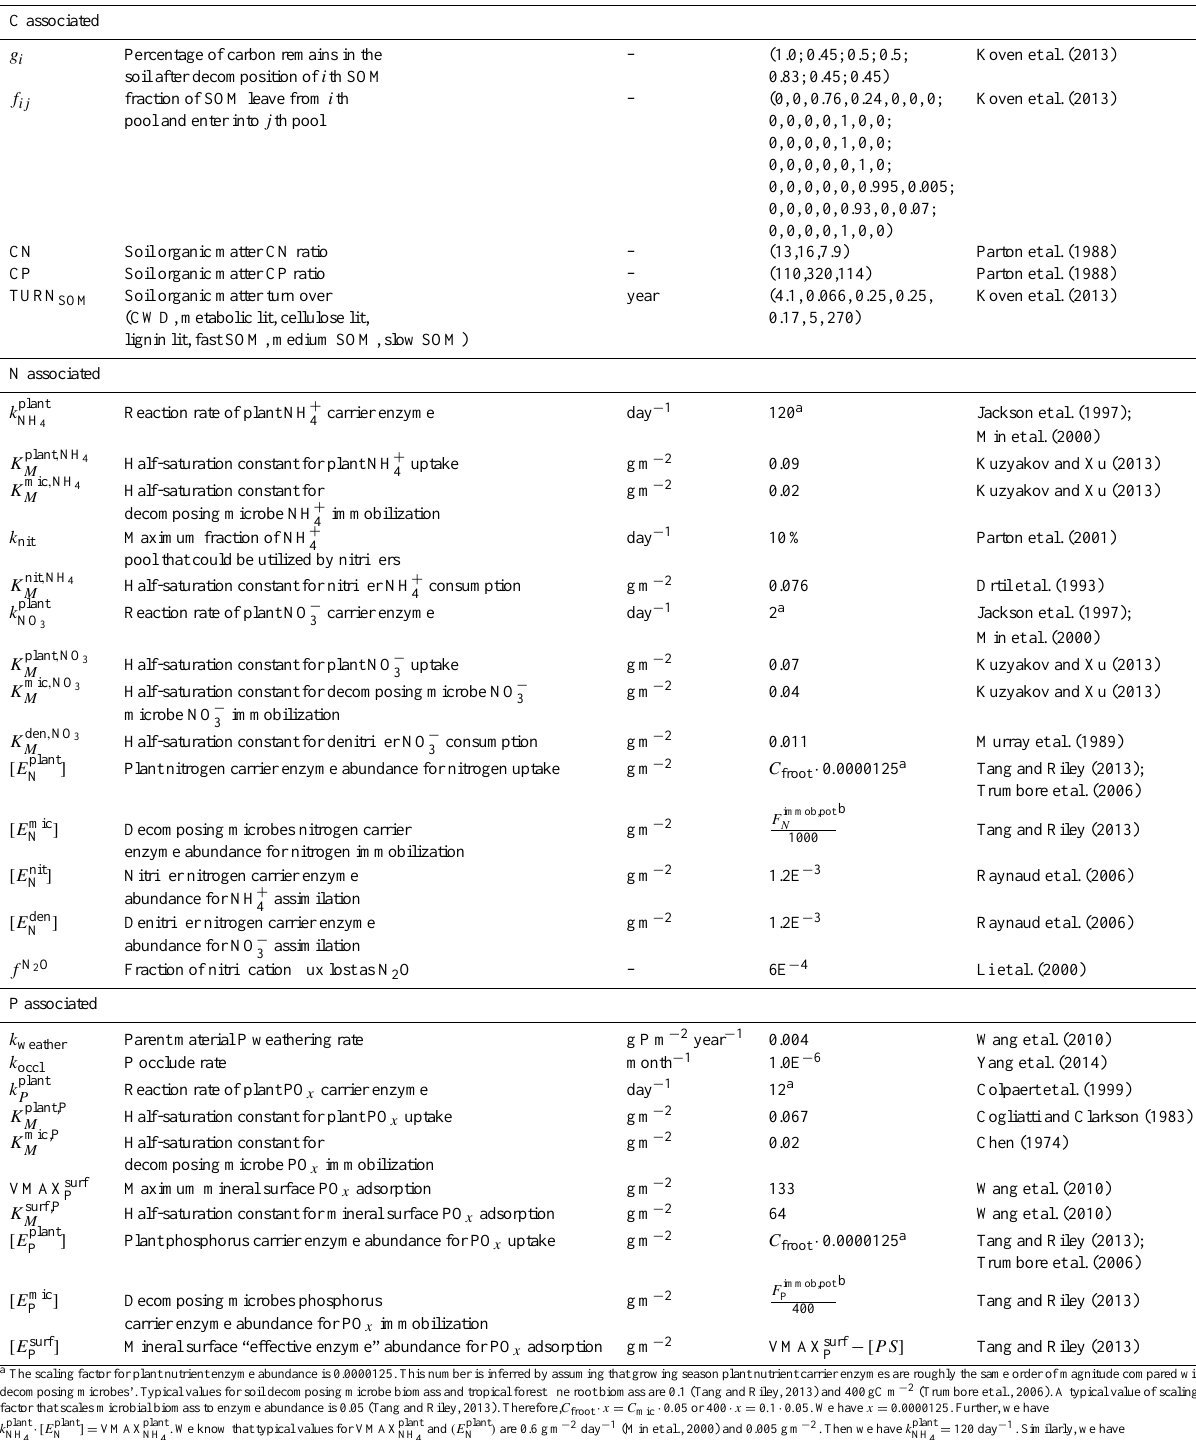
Table 2. Model parameters and baseline